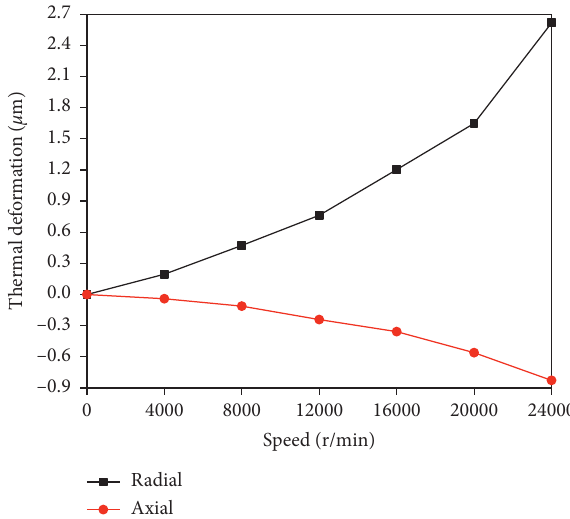
Figure 9: Influence of speed on thermal deformation.